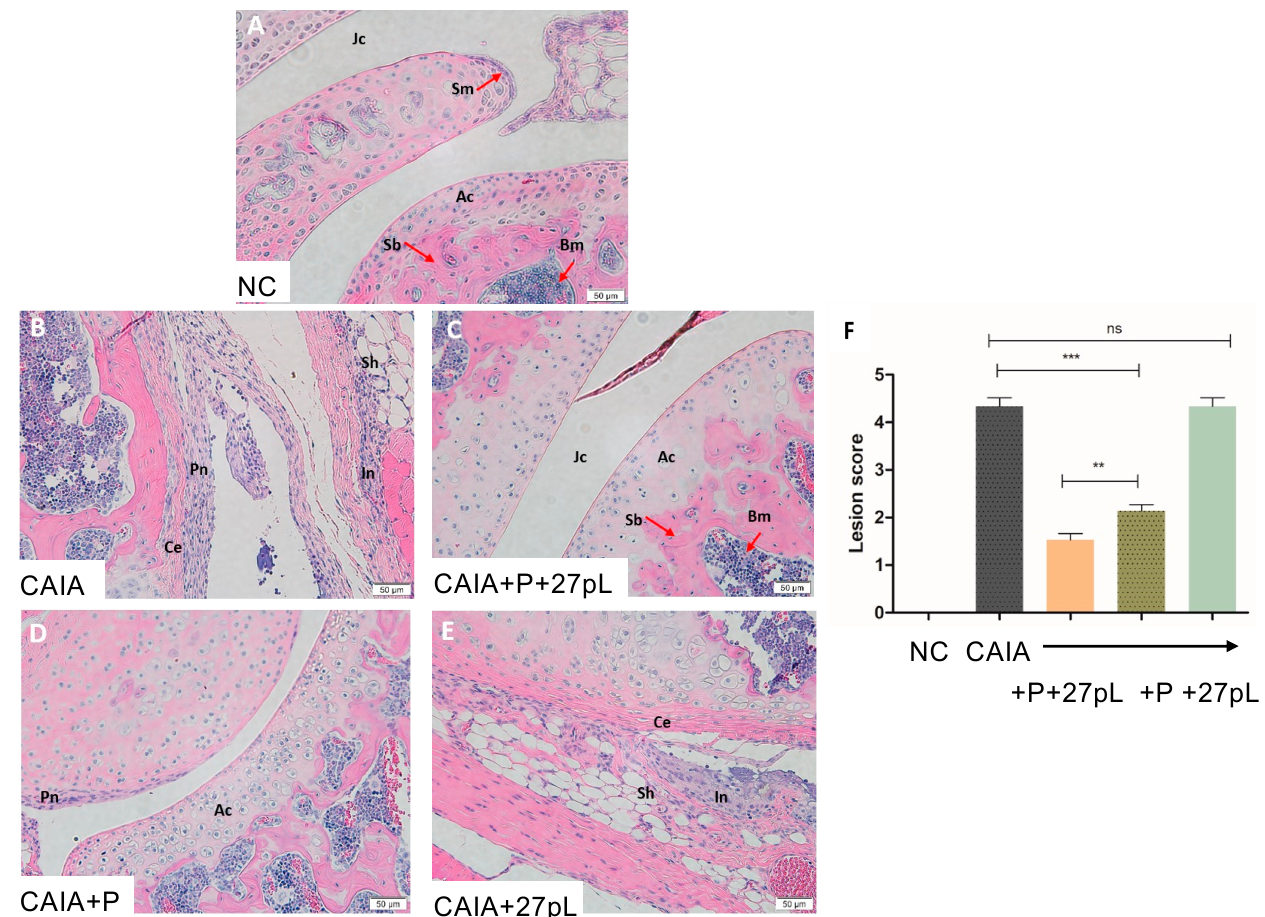
Figure 4. Histopathological analysis of the knee joint. ( A ) No CAIA control (NC, -ctrl) knee showing articular cartilage (Ac), synovial membrane (Sm), subchondral bone (Sb), bone marrow cells (Bm), and the joint cavity (Jc). ( B ) CAIA mice (+ctrl) showed hyperplastic synovium (Sh) with increased Pannus formation (Pn) and Cartilage erosion (Ce). ( C ) Treatment of the CAIA mice with prednisone P + 27pL showed a lack of hyperplastic synovium, inflammation, and pannus formation. The joint cavity (Jc), articular cartilage (Ac), Subchondral bone (Sb) and Bone marrow (Bm) were similar to NC. ( D ) Treatment of CAIA mice with P showed only a low decrease in Pannus formation (Pn), and articular cartilage (Ac) integrity was preserved. ( E ) CAIA mice treated with 27pL showed hyperplastic synovium (Sh), inflammation (In), pannus formation (not shown), and cartilage erosion (Ce). ( F ) Total lesion scores indicated increased inflammatory lesions in the CAIA mice. Treatment with P reduced the lesion score of knee joints, and 27pL expression potentiated the effect of P. Results represent mean ± SEM. A one-way analysis of variance (ANOVA) followed by Tukey’s multiple comparison t -test was used to calculate the statistical difference. The Mann–Whitney non-parametric test was used to calculate the statistical difference between P and P + 27pL (** p ≤ 0.01; *** p < 0.001), with ns, not significant.